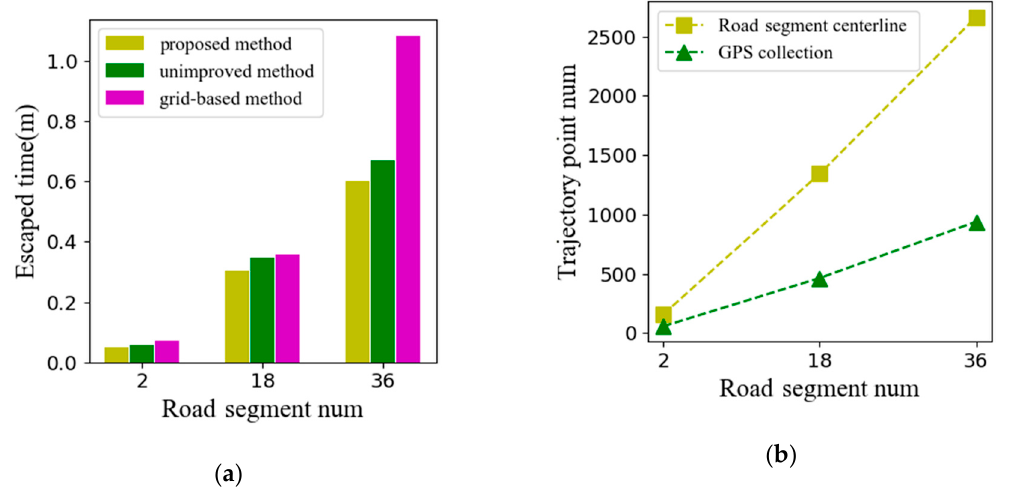
Figure 12. Algorithm efficiency results: ( a ) Elapsed time under different data quantities obtained by unimproved, grid-based, and proposed algorithms; ( b ) number of collection trajectories and number of road centerline trajectories with different road segment numbers.